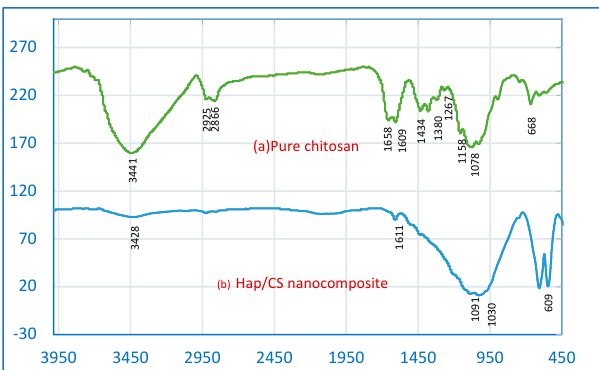
Figure 1. FTIR spectra of ( a ) pure chitosan and ( b ) hydroxyapatite (Hap)/chitosan (CS) nanocomposite.